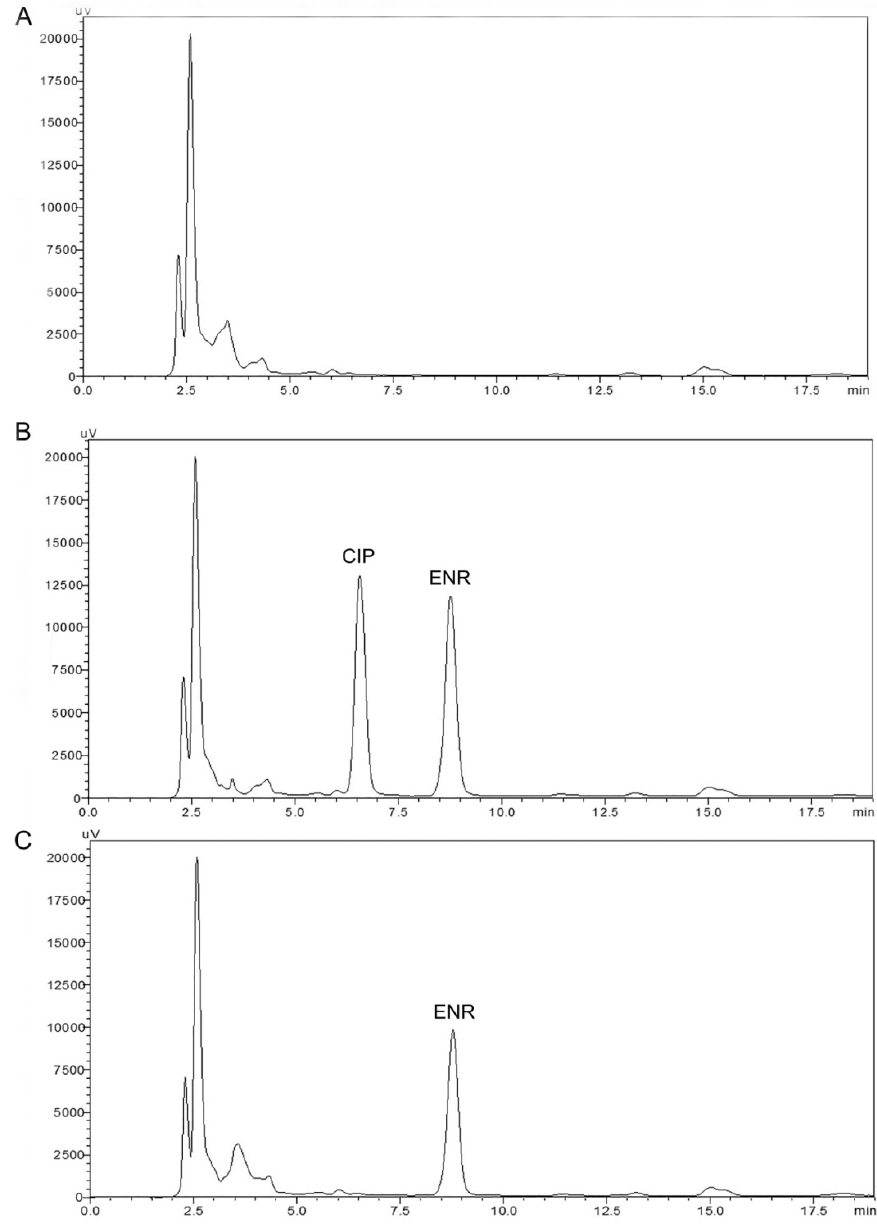
Figure 1. Representative chromatograms of blank brown trout plasma ( A ); brown trout plasma spiked with enrofloxacin and ciprofloxacin (10 μ g/mL) ( B ); and brown trout plasma sample at 8 h after oral administration of enrofloxacin at dose of 20 mg/kg ( C ). ENR, enrofloxacin, CIP, ciprofloxacin. The chromatographic method was validated according to EMA (2011) guidelines